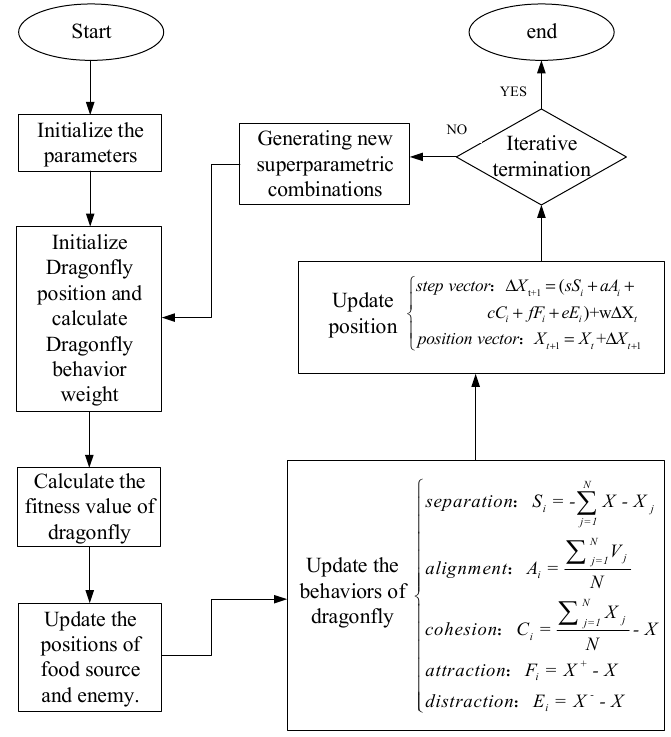
Figure 2. Flowchart of dragonfly algorithm-support vector quantile regression (DA-SVQR).